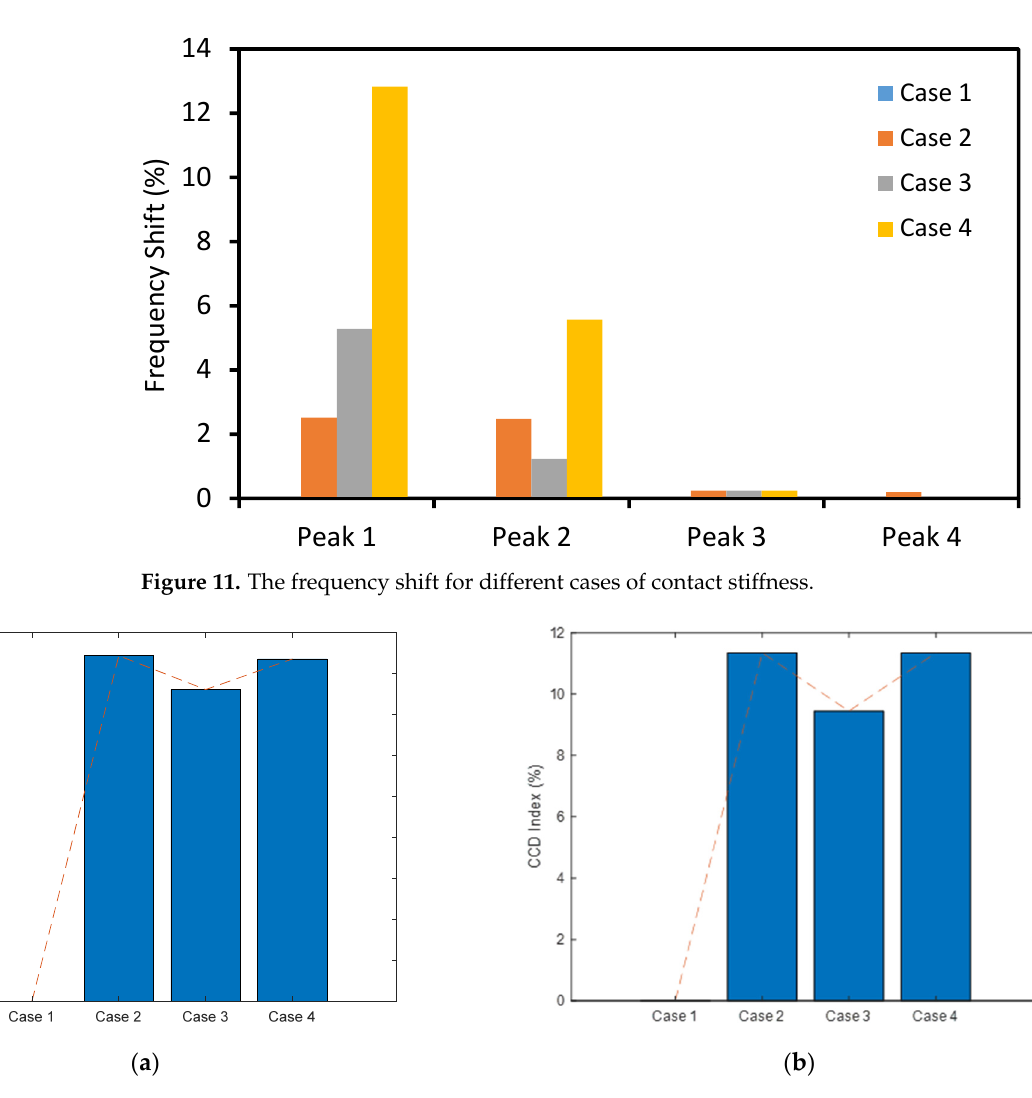
Figure 13. The damage indices for the frequency range of 70–80 kHz. ( a ) RMSD index; ( b ) CCD index.